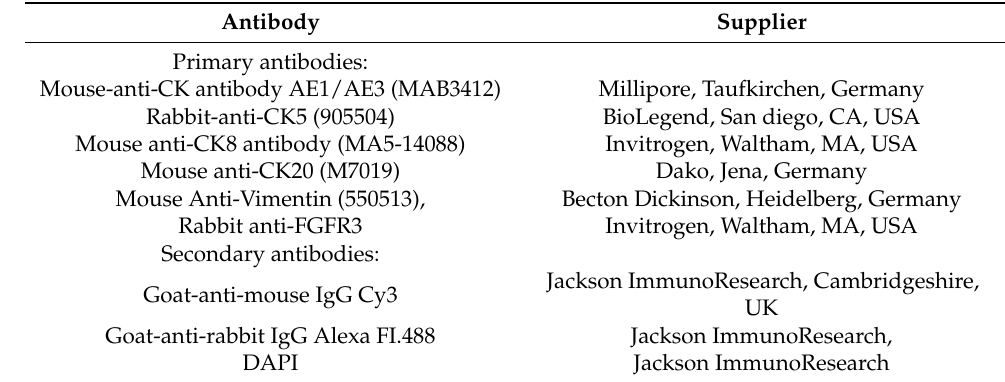
Table 3. Reagents for immunofluorescence